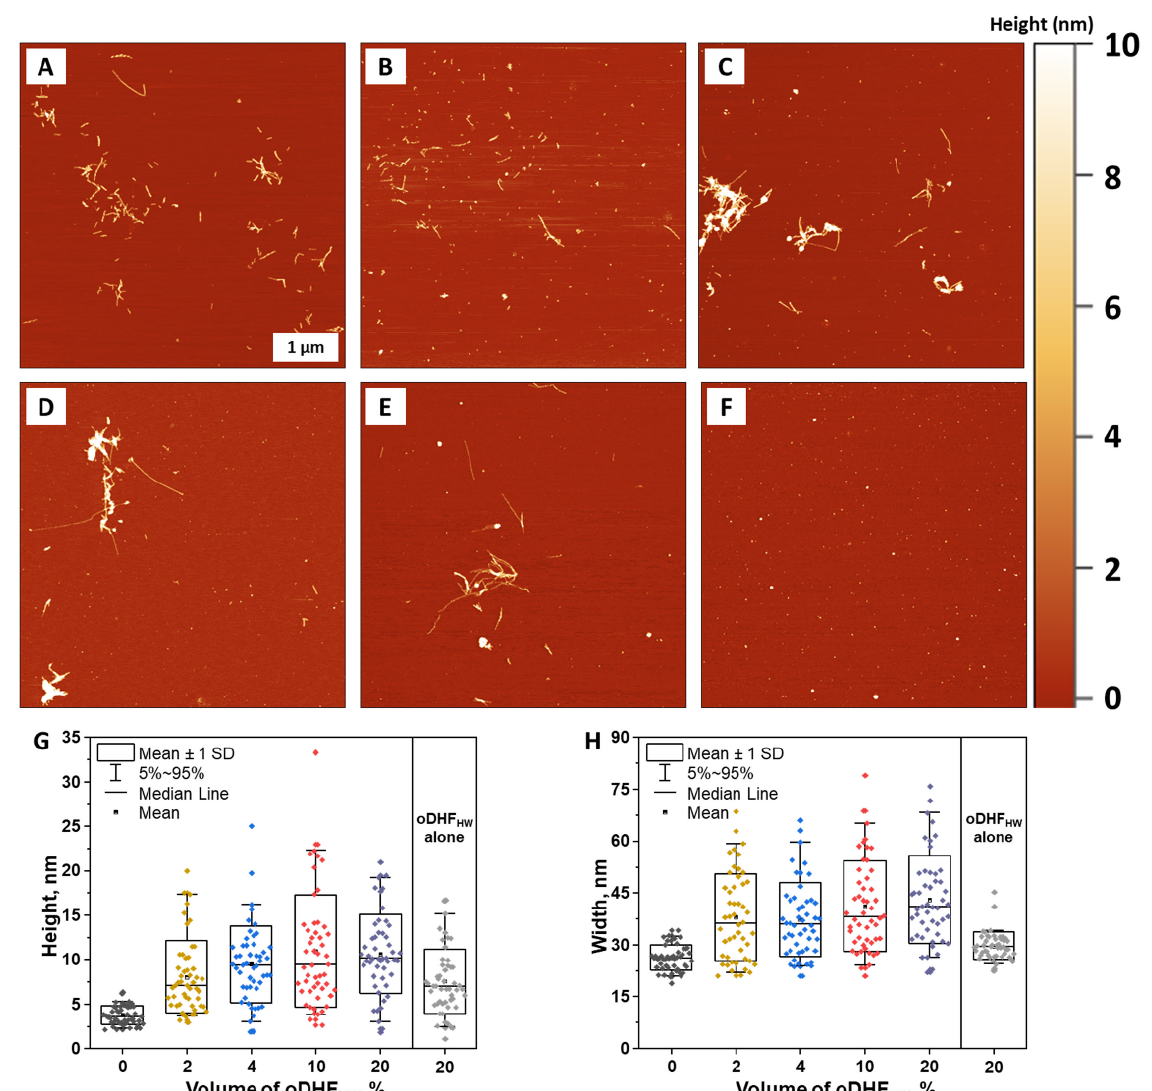
Figure 3. Atomic force microscopy (AFM) images of A β without ( A ) and with 1% ( B ), 4% ( C ), 10% ( D ) and 20% ( E ) oDHF HW concentration and the 20% of oDHF HW alone ( F ). The height ( G ) and width ( H ) distribution of structures present on the mica, where box plots indicate mean ± SD and error bars are in the 5–95% range (n = 50).